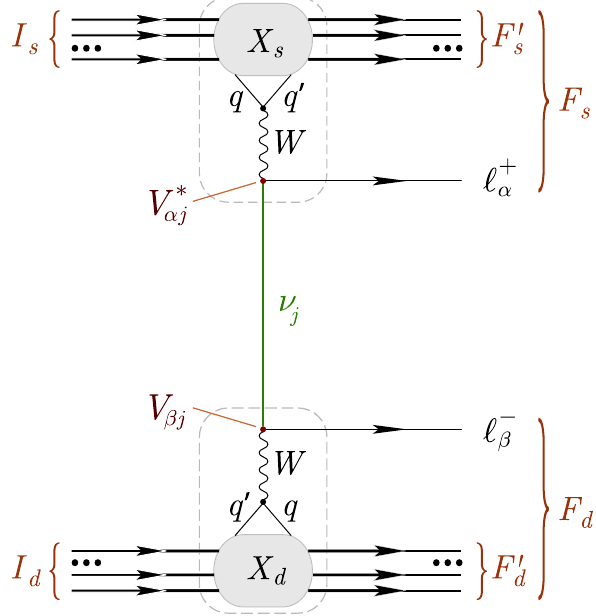
Fig. 2 A diagram of process (10), see text for details